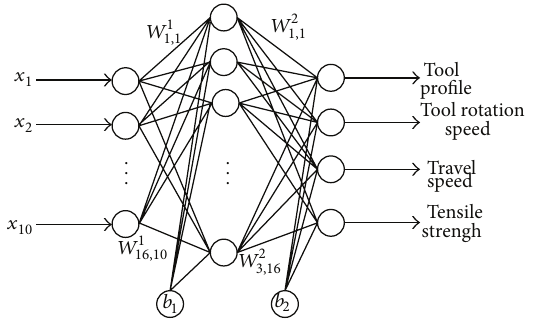
Figure 7: Topology of ANN.